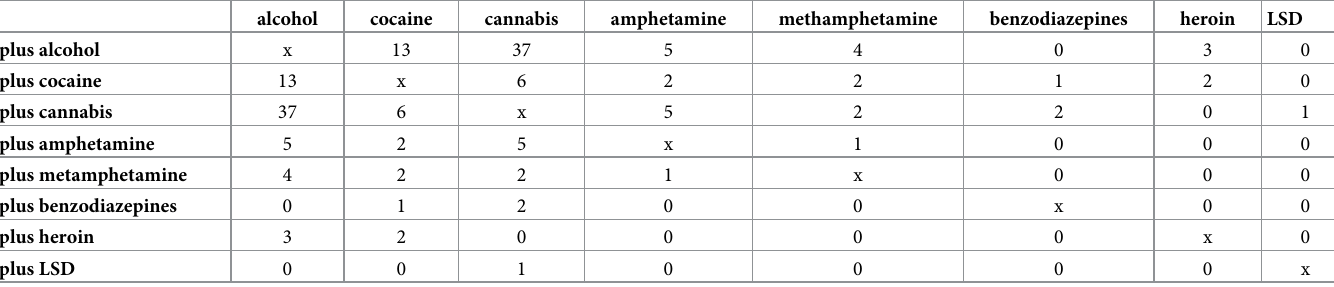
Table 2. Reported substances in cases with use of more than one